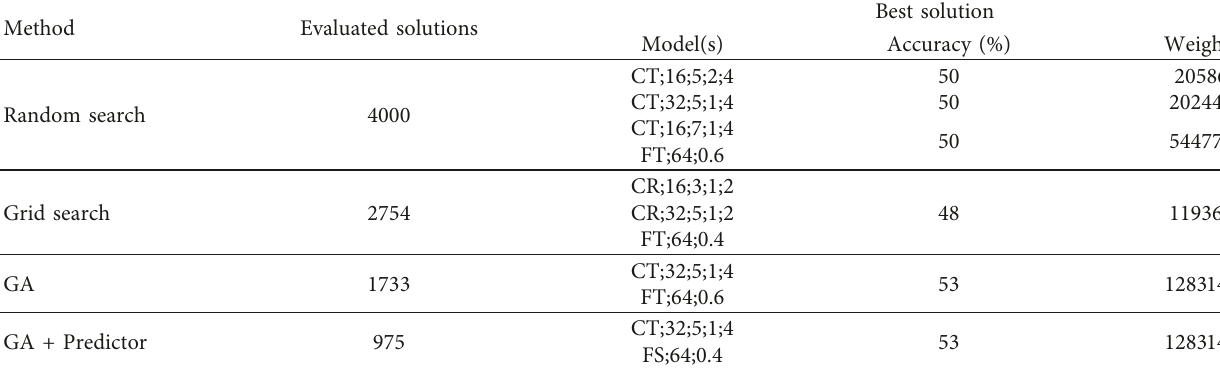
Table 6: CIFAR-10